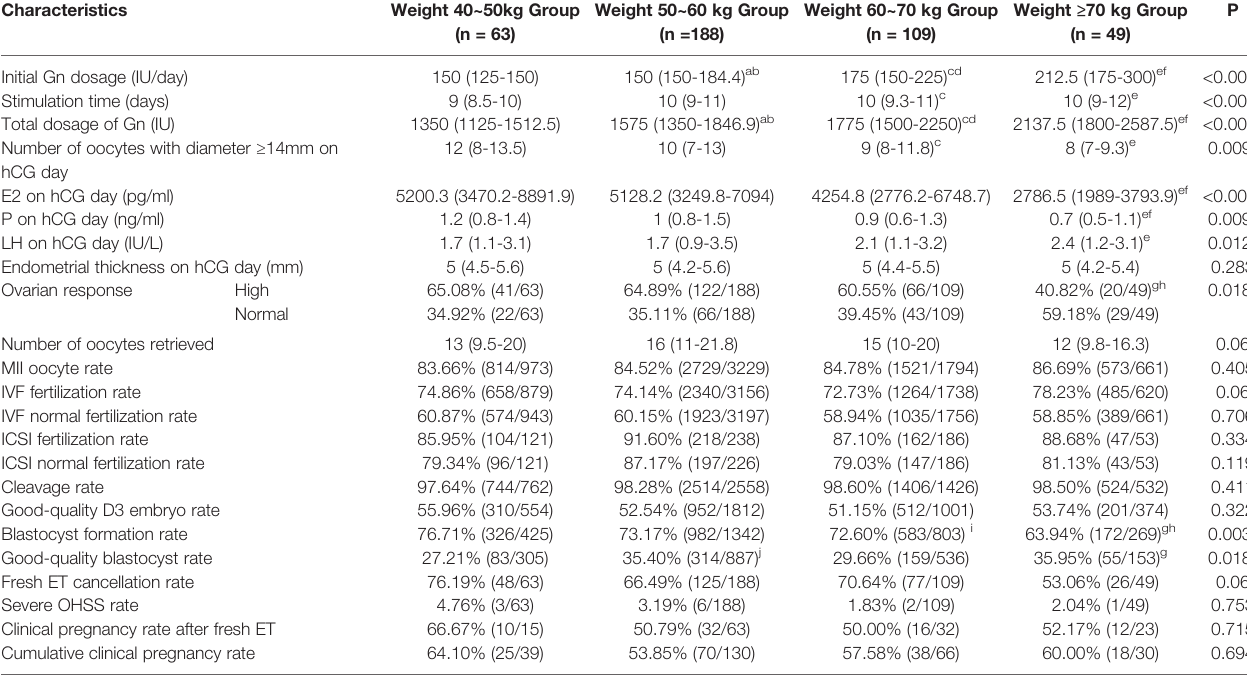
TABLE 2 | COS and clinical outcomes of PCOS patients in four body weight groups (n = 409).